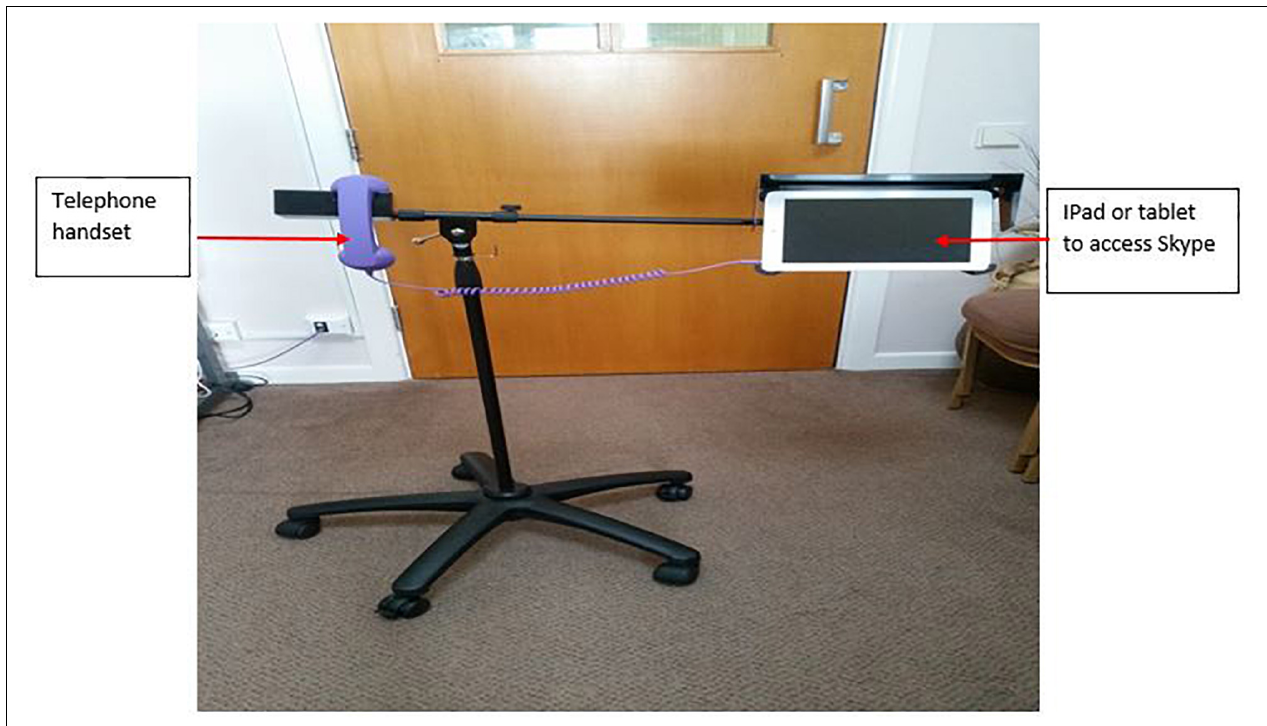
FIGURE 1 | Skype on wheels (SoW)